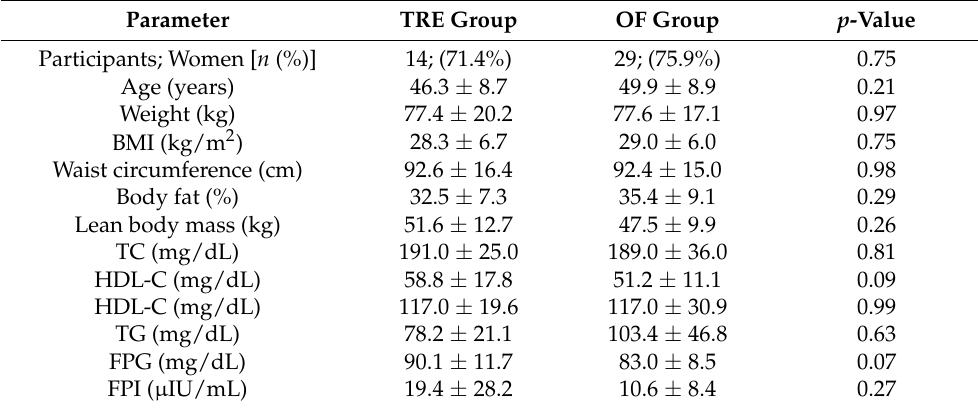
Table 1. Baseline features of the two groups. Parameter TRE Group OF Group p -Value Participants; Women [ n (%)] 14; (71.4%) 29;